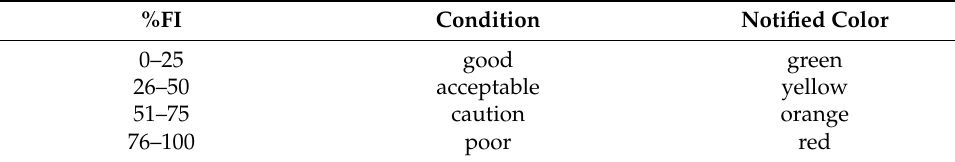
Table 7. %FI and condition determined by the key gas method.